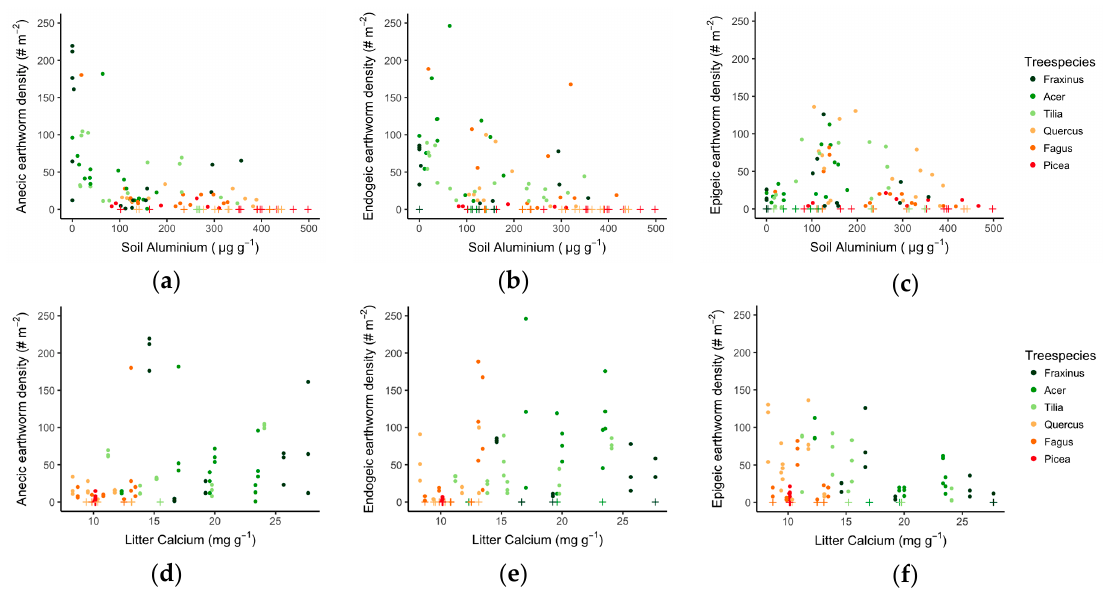
Figure 5. Relation between exchangeable Al concentration in the 0–5 cm soil layer ( a – c ) or Ca concentration in foliar litter ( d – f ), and density of anecic ( a , d ), endogeic ( b , e ), and epigeic ( c , f ) earthworms. Plots where zero earthworms were found are indicated by a cross symbol. The foliar litter Ca concentration was previously published by Vesterdal et al. [36].